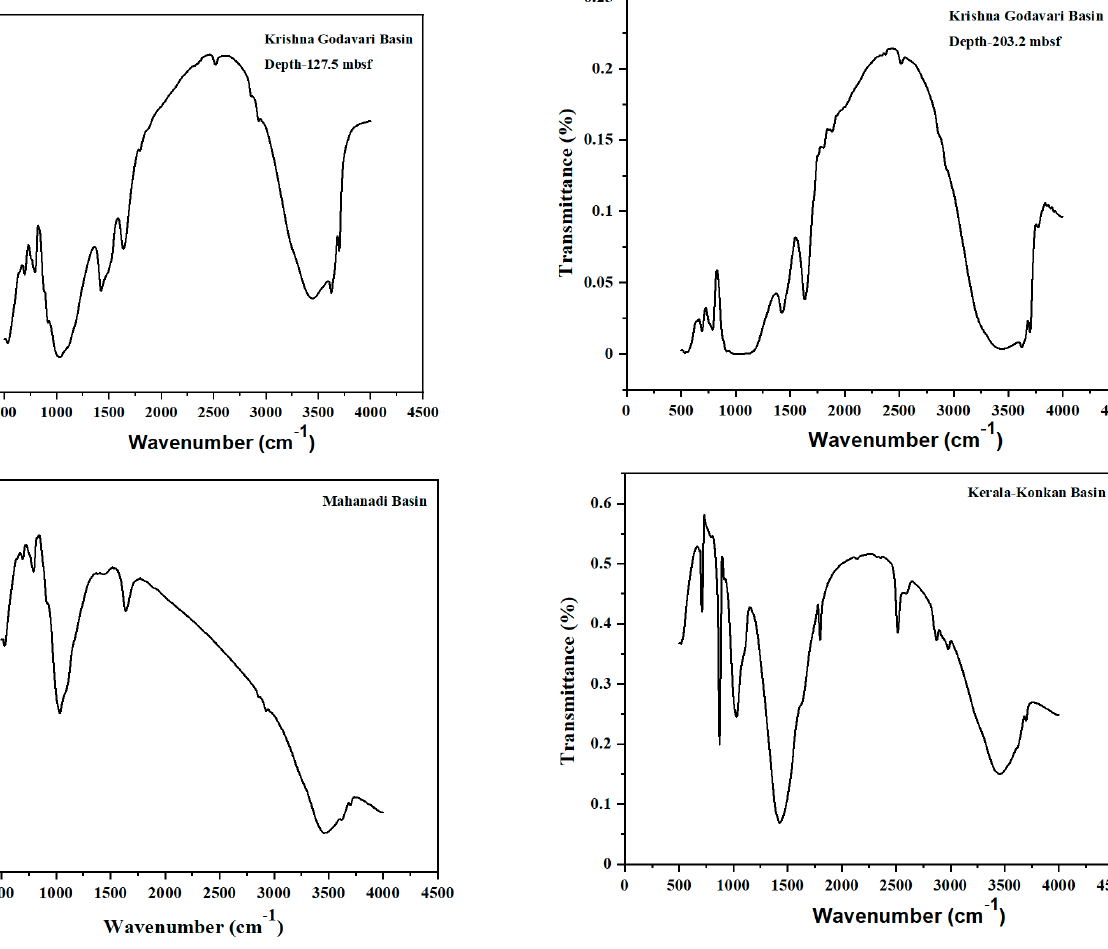
Figure 5. FTIR analysis.